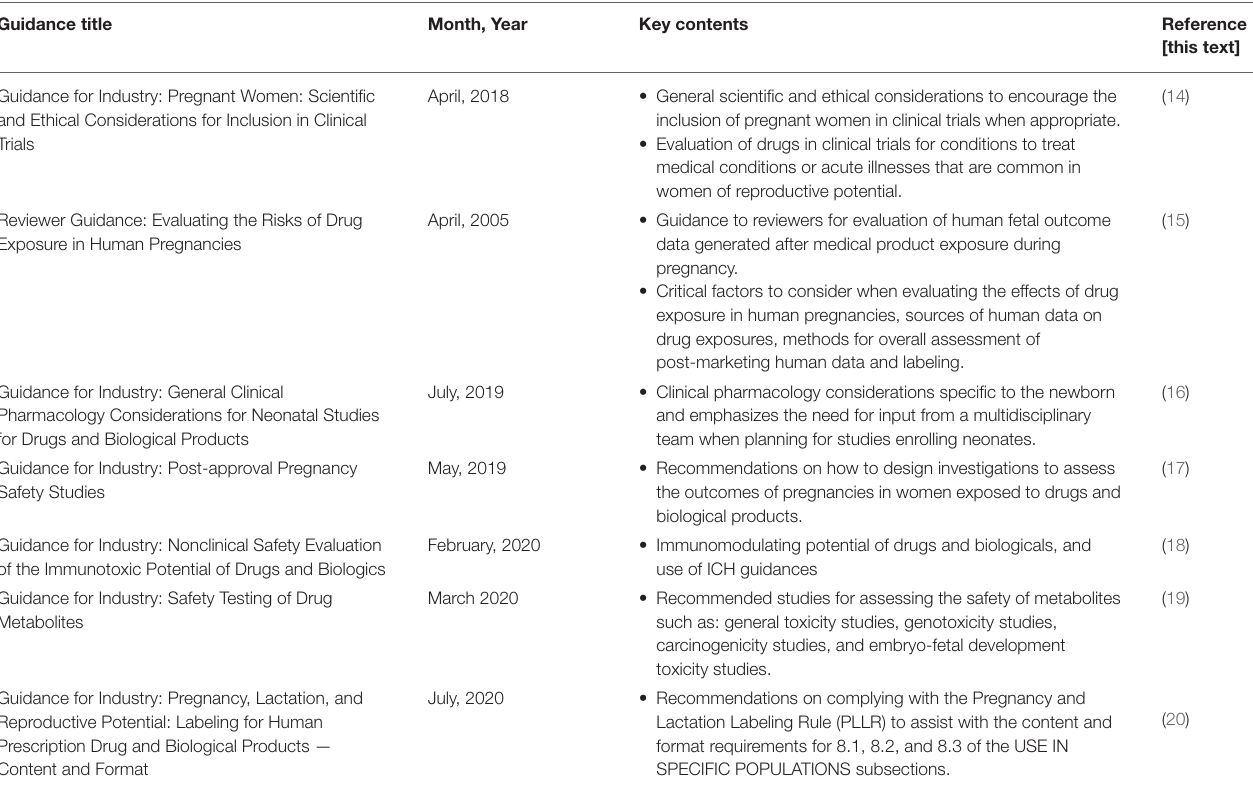
TABLE 1 | Summary of FDA guidances for the mother, fetus and